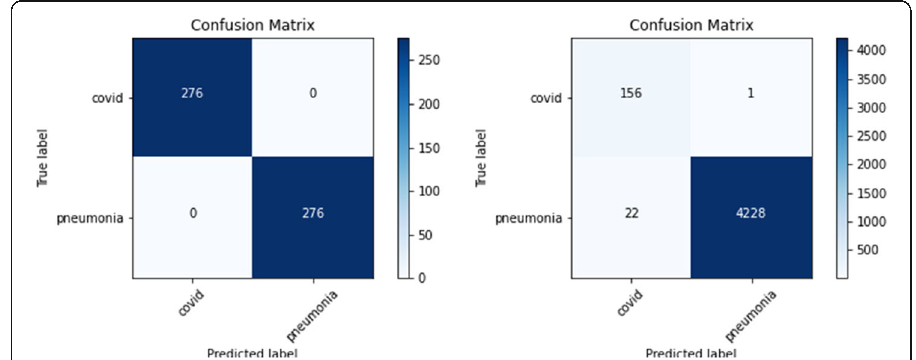
Fig. 15 DenseNet121 confusion